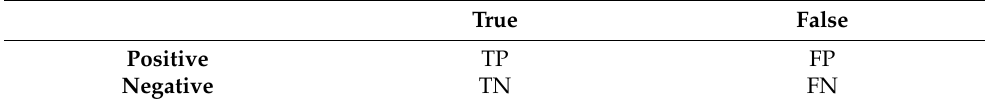
Table 3. Confusion